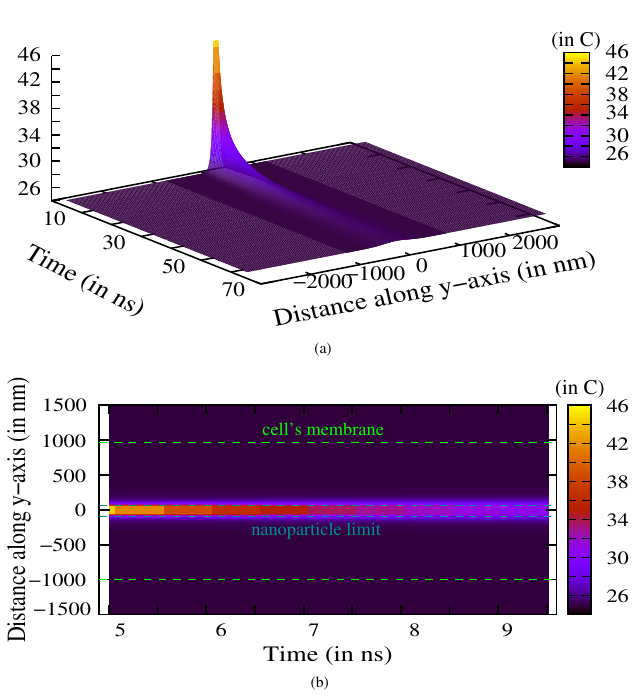
Figure 3. ( a ) Time evolution of the temperature (in ◦ C) in the cell (i.e., | y | ≤ 1000 nm) and in the water (i.e., | y | ≥ 1000 nm); ( b ) The spatial distribution of the temperature stays located in the near vicinity of the nanoparticle (i.e., at | y | ≈ 50 nm).